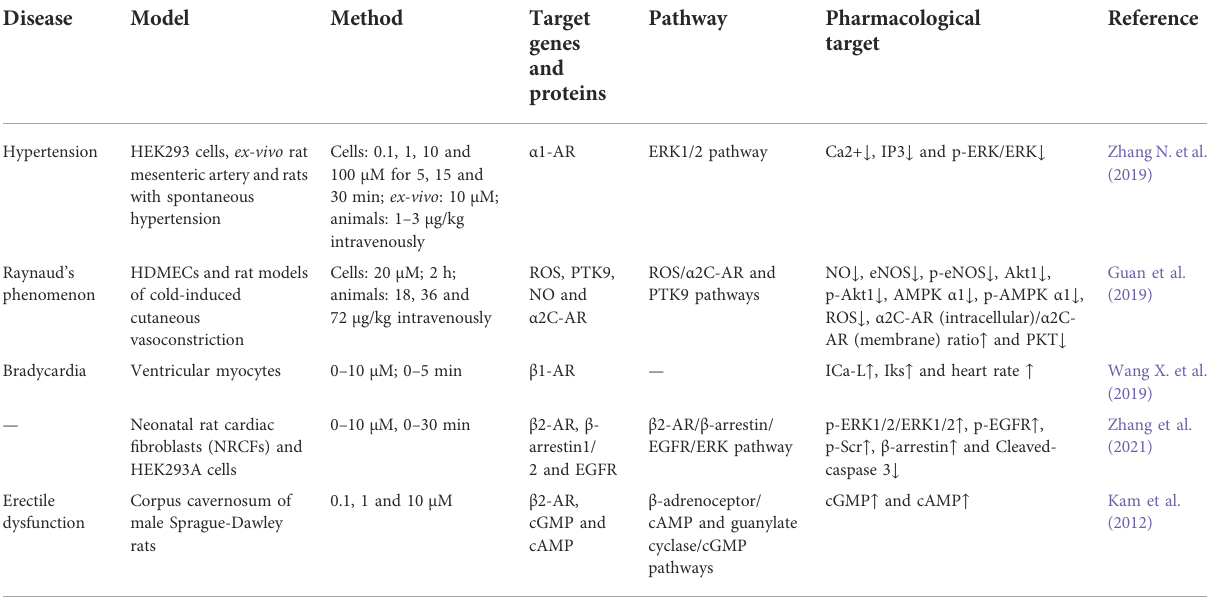
TABLE 3 Pharmacological effects of HG on